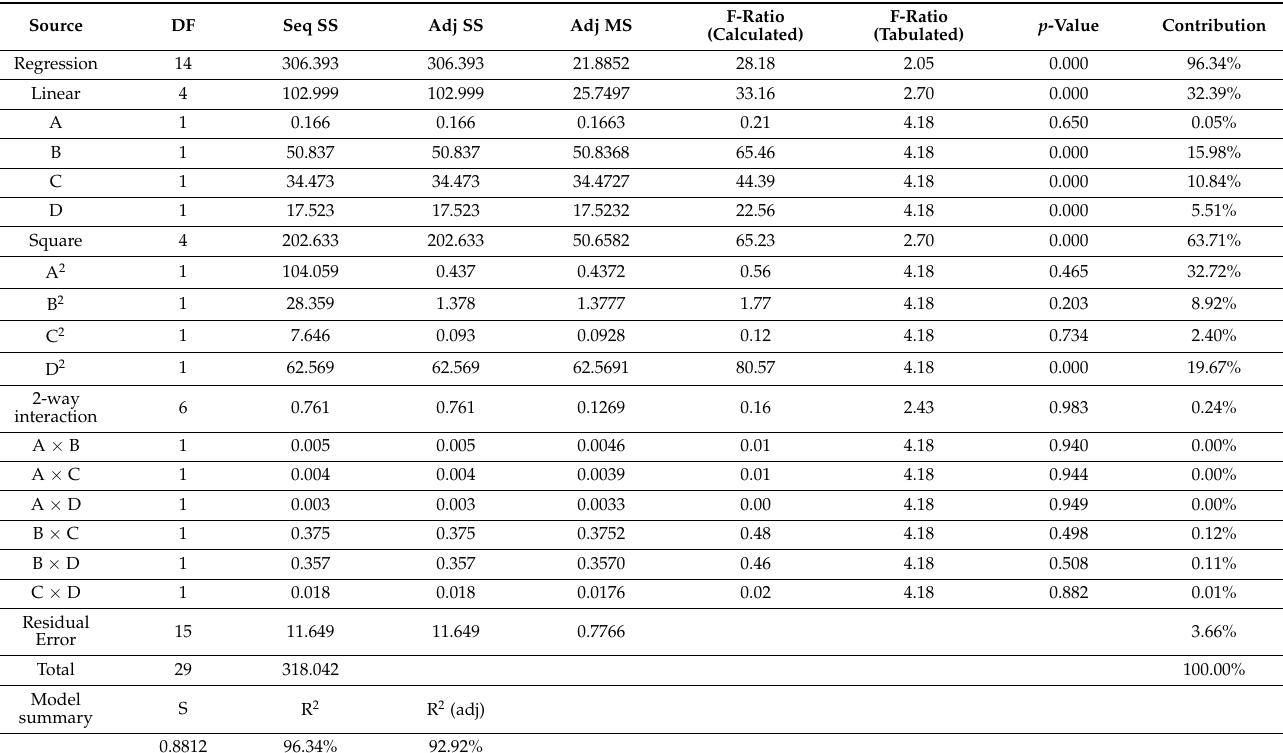
Table 14. ANOVA for thrust force of h-BN-loaded